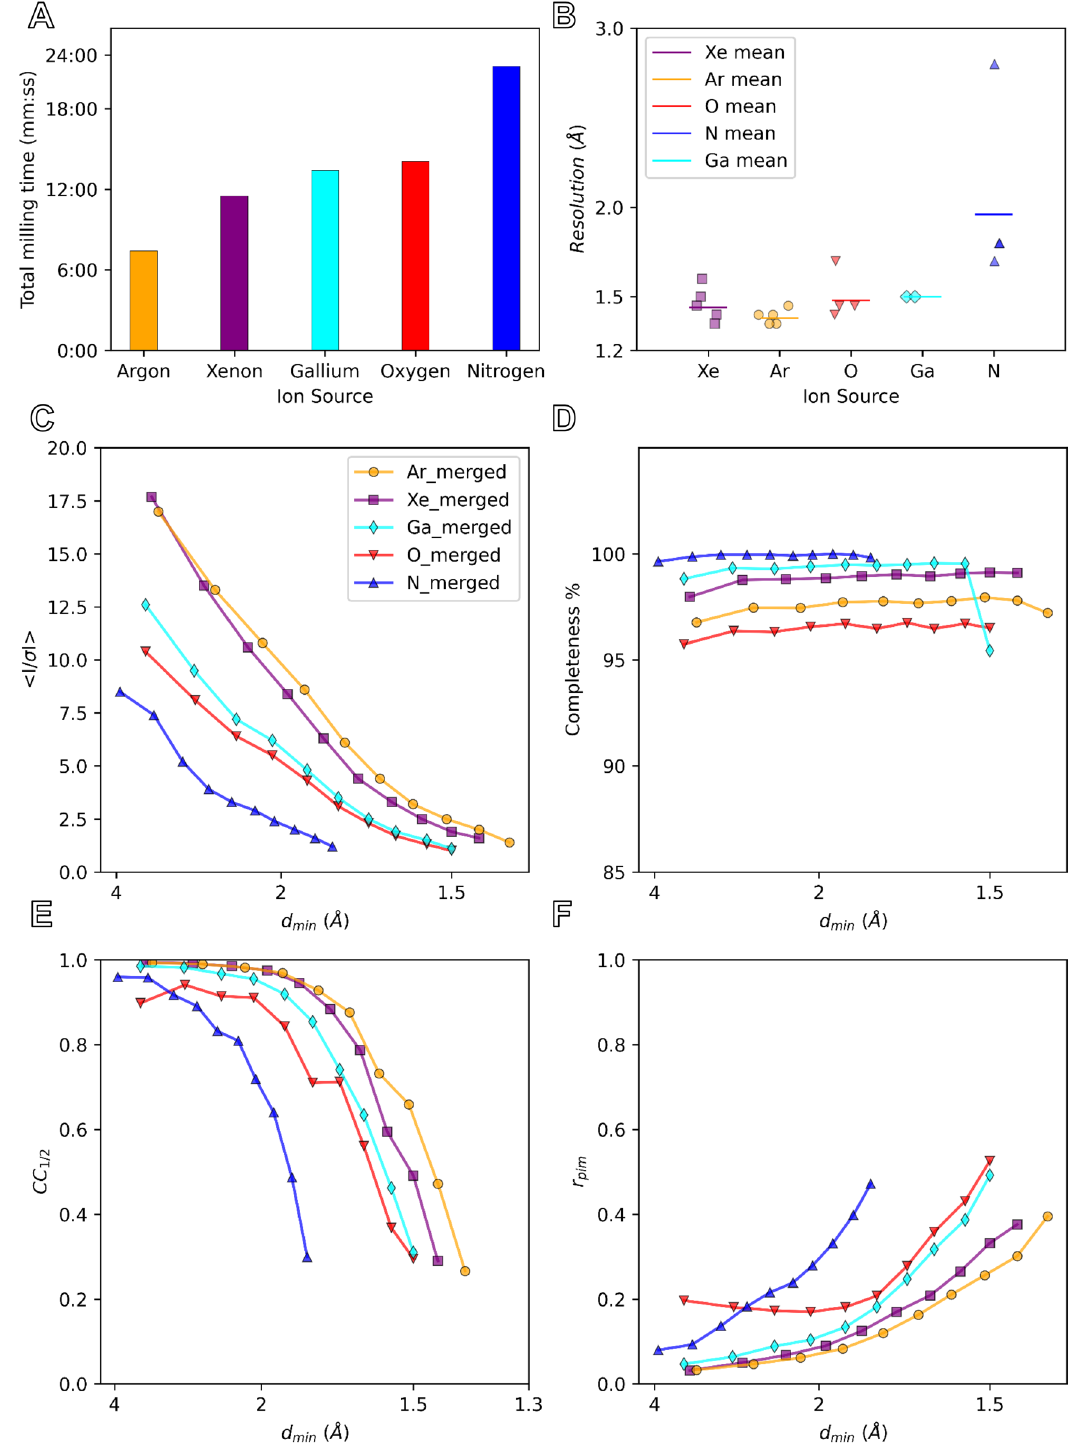
Fig. 3 | Crystallographic statistics for plasma ion-beam milled lamellae from different sources. Plots depict the total milling time ( A ), MicroED resolution ( B ), mean signal to noise ratio (<I / σ (I)>) ( C ), completeness (%) ( D ), mean half-set correlationcoef fi cient(CC 1/2 )( E ),andmergedmultiplicitycorrectedRfactor(R pim ) ( F ) asfunctions of the d min resolution bins (Å). The merged datasets are solid lines